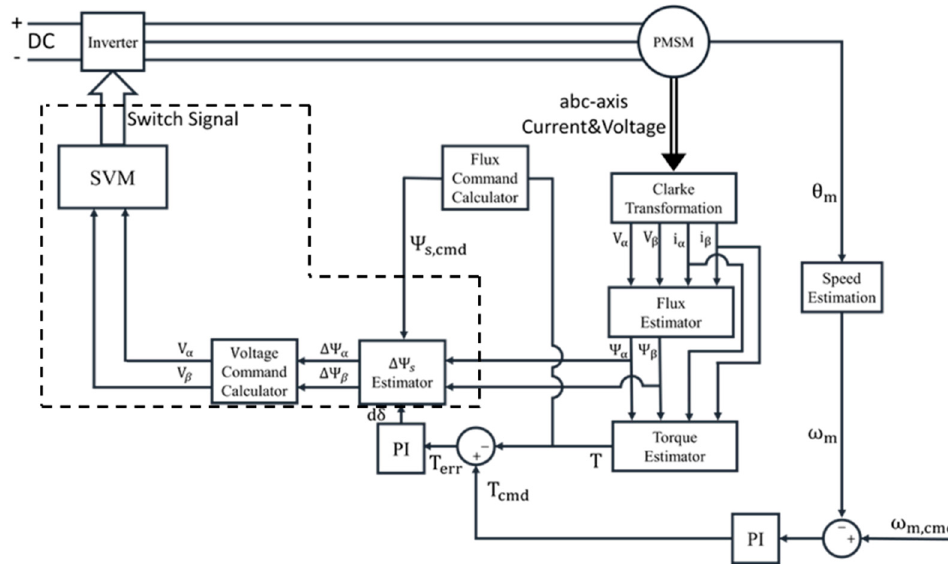
Figure 4. Overall block diagram of conventional SVM-DTC for PMSM [19].